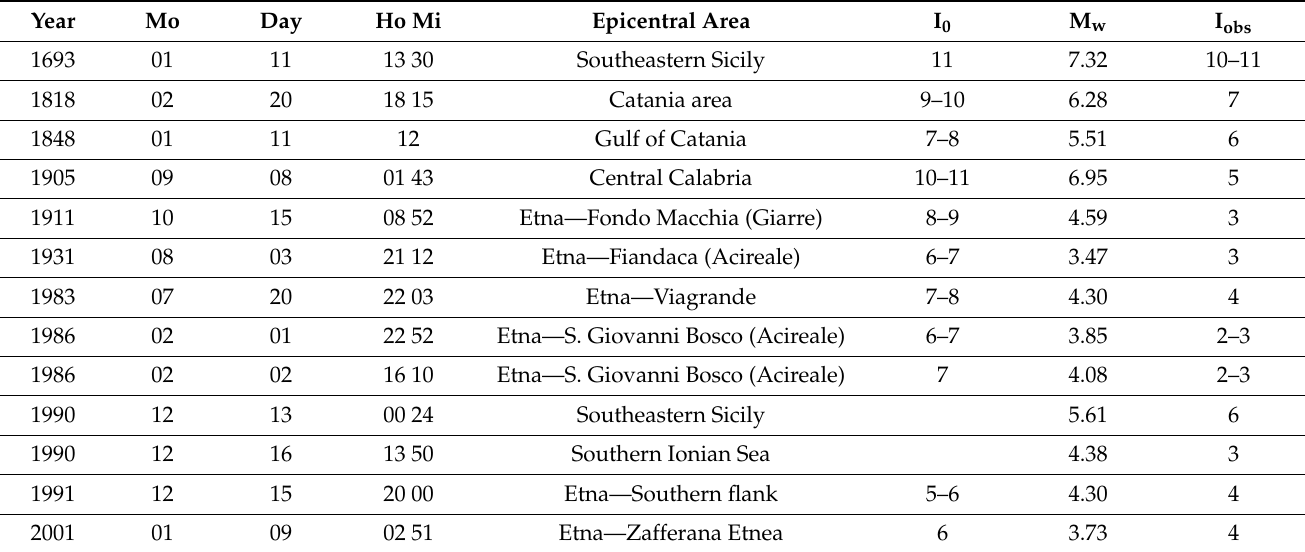
Table 2. Observed intensity at Aci Castello. I0 is the epicentral intensity, Mw is the equivalent magnitude, Iobs is the observed MCS (Mercalli–Cancani–Sieberg) intensity according to Rovida et al.